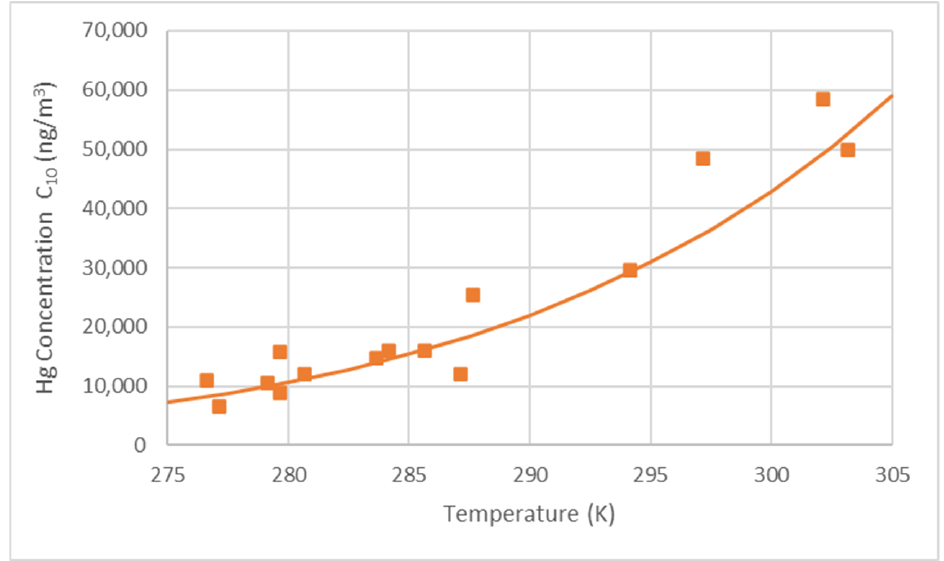
Figure 9. Hg concentration C 10 vs. temperature; measured (dots) and calculated using the model based on Arrhenius theory (line).